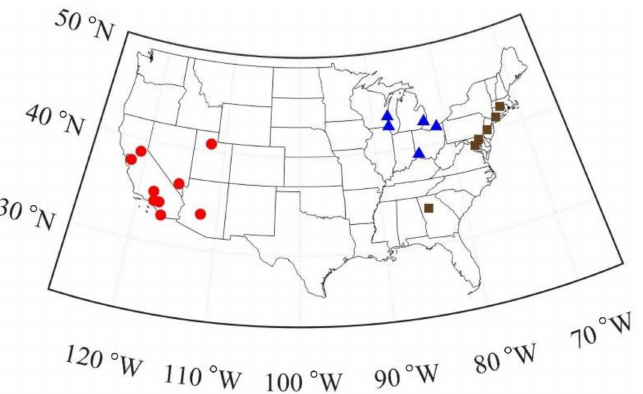
Figure 1. Map showing the locations of the O 3 monitoring sites for the urban nonattainment areas (NAAs) in the eastern U.S. (brown squares), midwestern U.S. (blue triangles), and western U.S. (red circles). See Table S1 for a list of the urban NAAs for the eastern, midwestern, and western U.S. The annual (May–September) slope of the MDA8 O 3 versus TMAX relationship (m O3-T ) was determined for each site using robust linear regression with bisquare